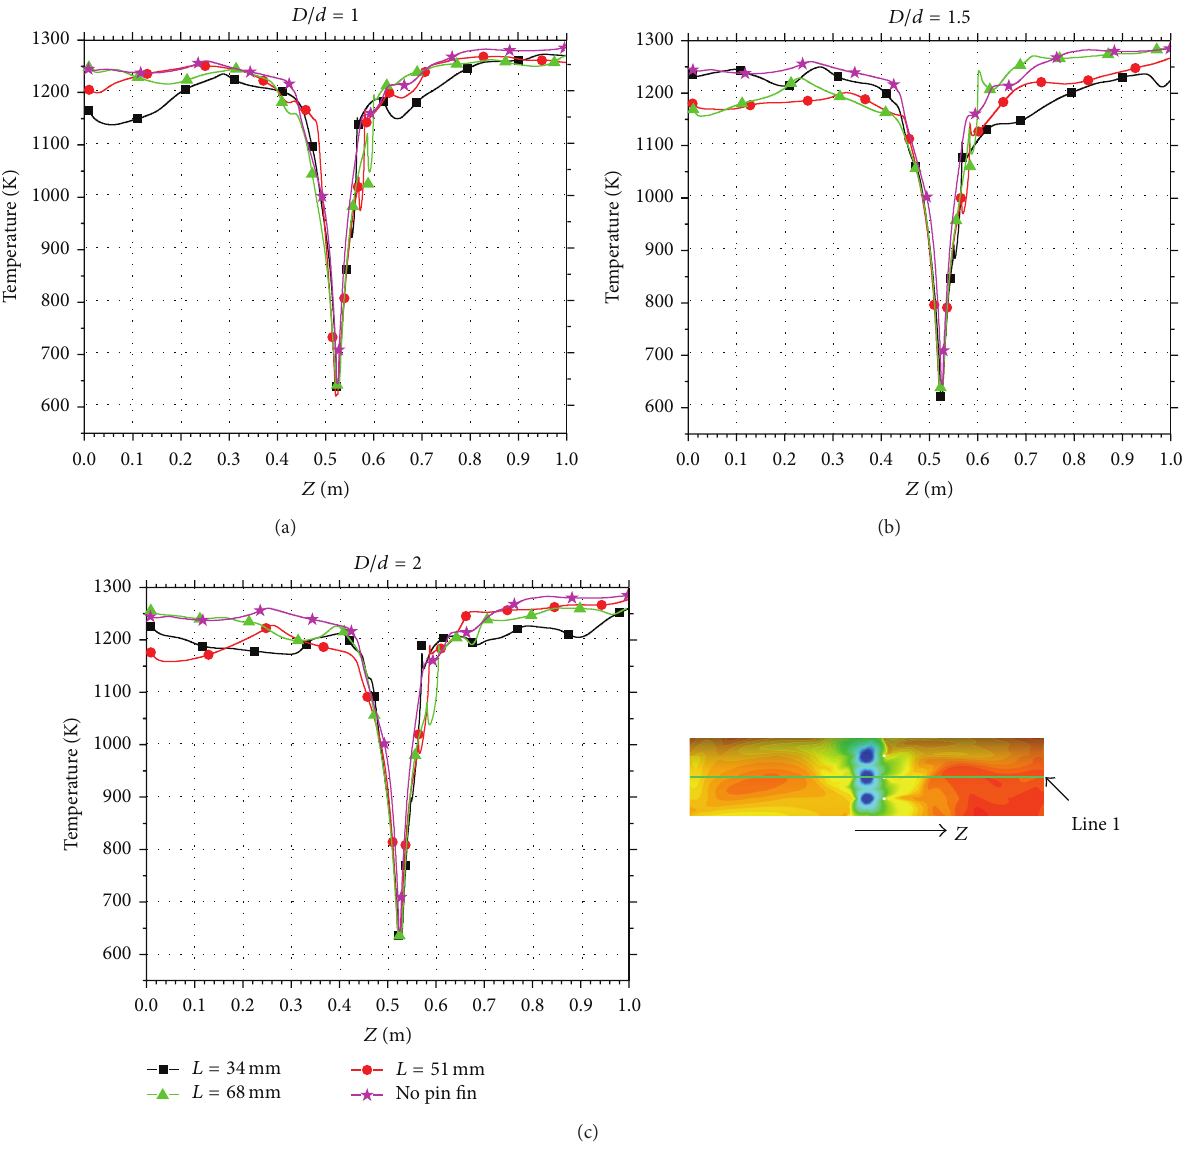
Figure 5: Comparison curves of 𝑇 𝑤 in Line